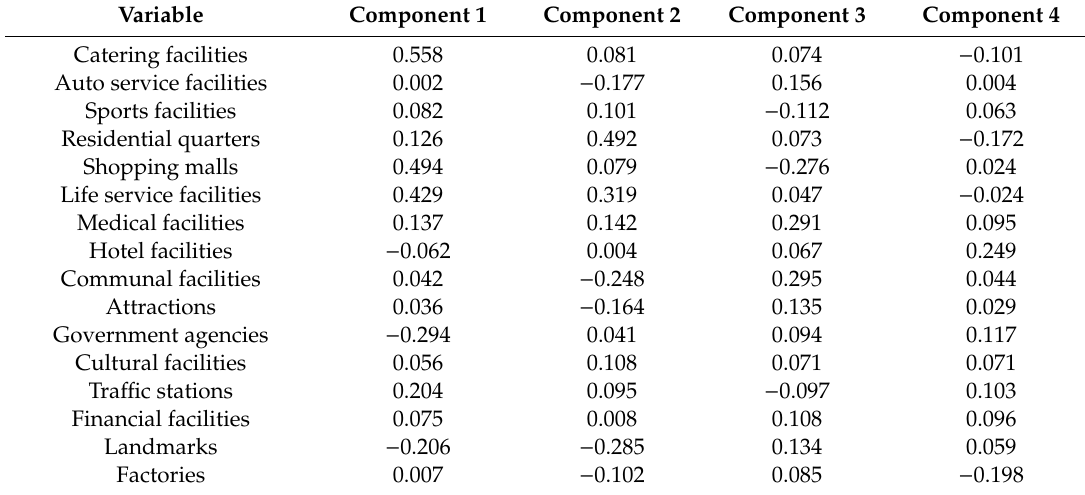
Table 4. Relationship between Components 1–4 and the 16 categories of